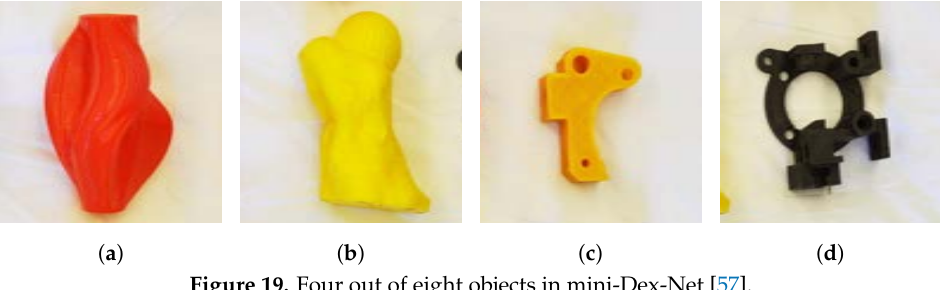
Figure 19. Four out of eight objects in mini-Dex-Net [57].